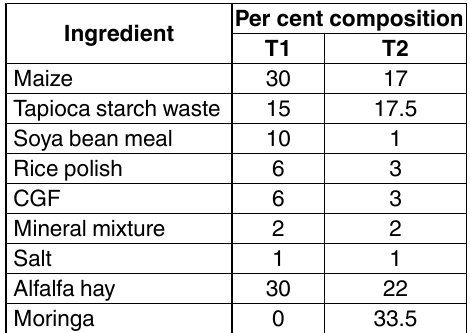
table 1 . Ingredient composition of control and experimental feed (%) Ingredient